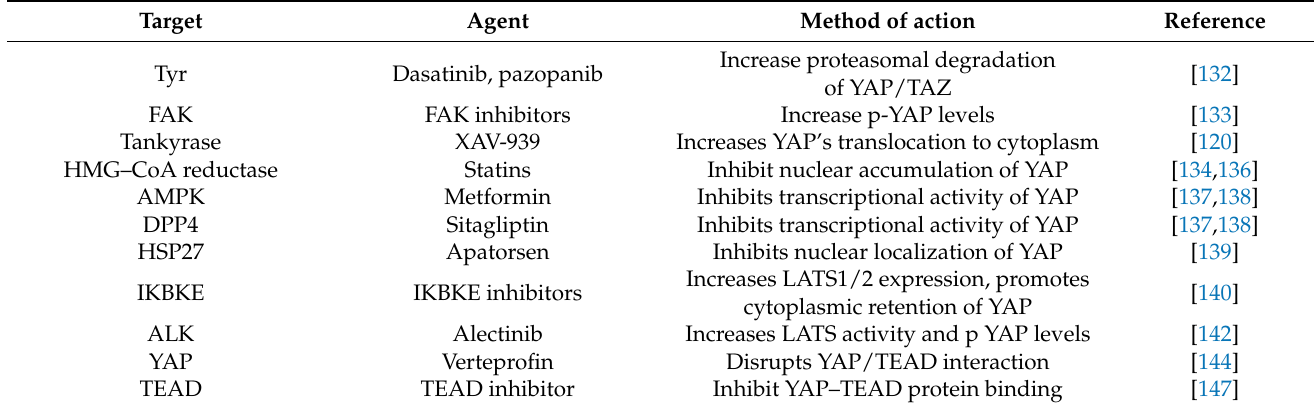
Table 1. Proposed strategies to target the Hippo pathway in prostate